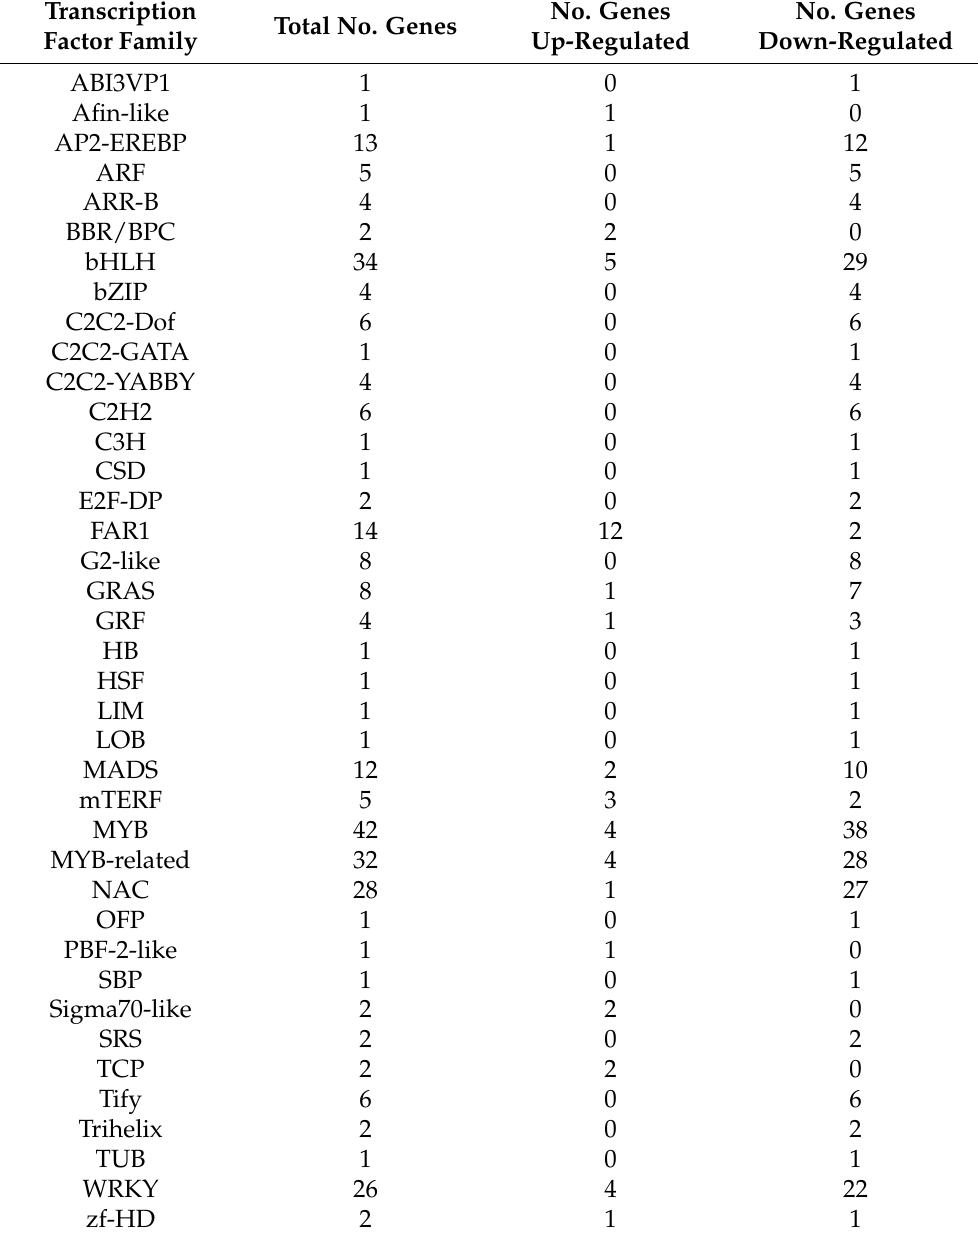
Table 2. Summary of differentially expressed transcription factor genes in chlorophyll b -deficient ( ch11 ) rice compared with wild-type